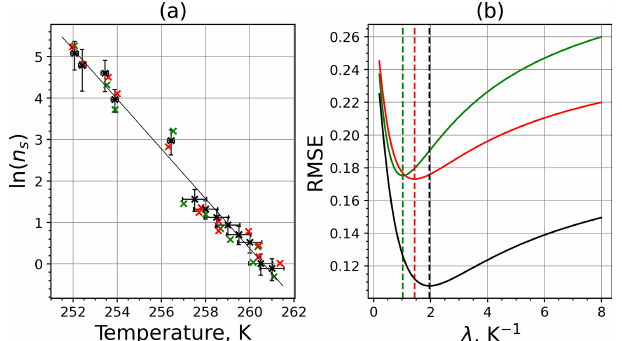
Figure 10. (a) Original (black; same as in Fig. 9a) data set and two data sets randomly generated within the experimental error interval (red and green) using the measured INAS densities of kaolinite. The solid black line is the linear fit to the original experimental data set. (b) RMSE as a function of lambda for 2 of the 1000 randomly generated data sets. The dashed vertical lines indicate the optimal lambda values for the red, green, and black curves.